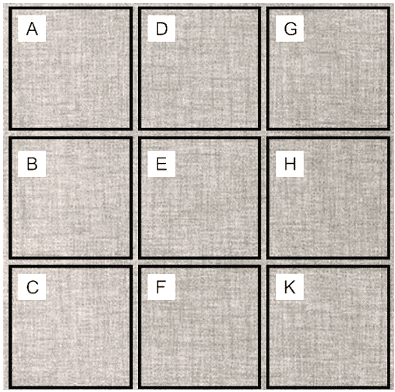
Figure 1. Sample surface division.